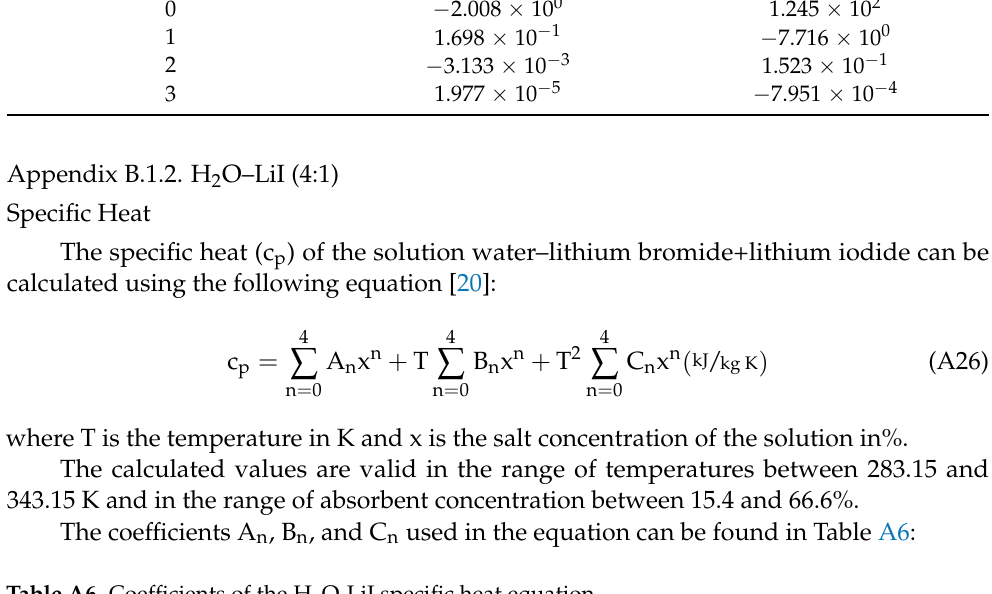
Table A6. Coefficients of the H 2 O-LiI specific heat